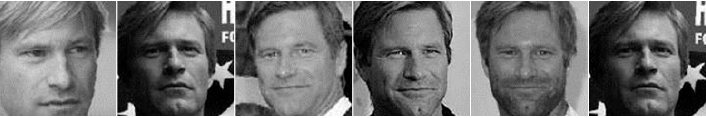
Figure 8. Some samples of one person on the PubFig database.